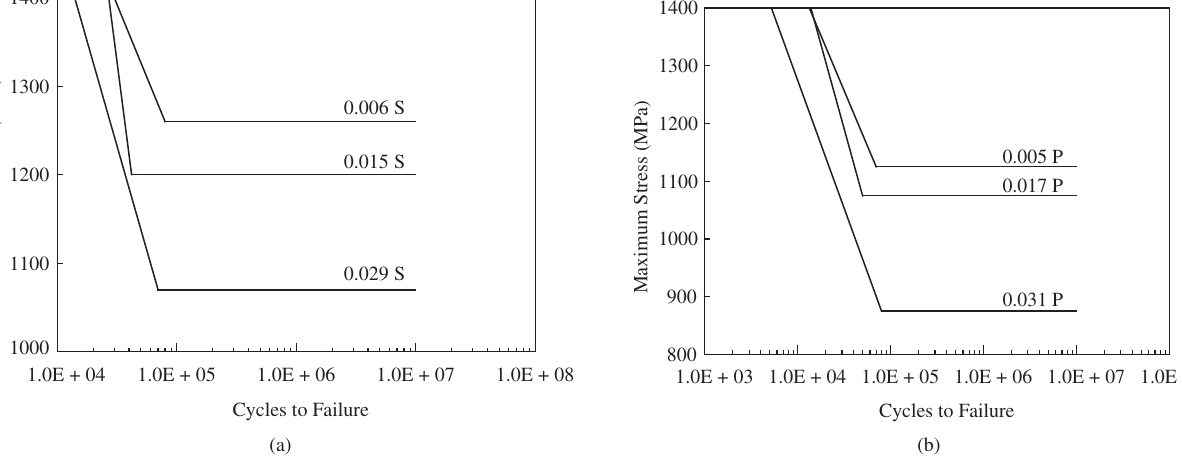
Figure 3. Effects of sulfur and phosphorus on the fatigue performance of a) SAE 8219 modified steel 1 ; and b) SAE 4320 modified steel 15